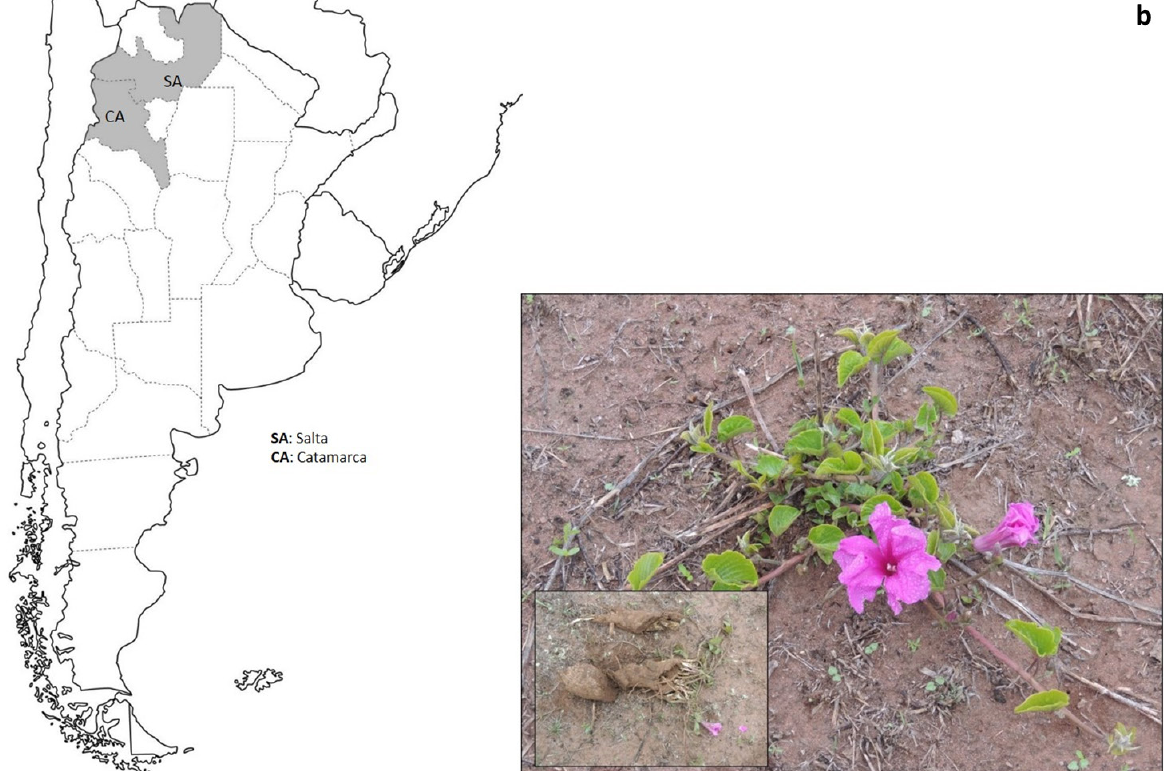
Figure 2b. Distribution of Ipomoea hieronymi subsp. calchaquina in